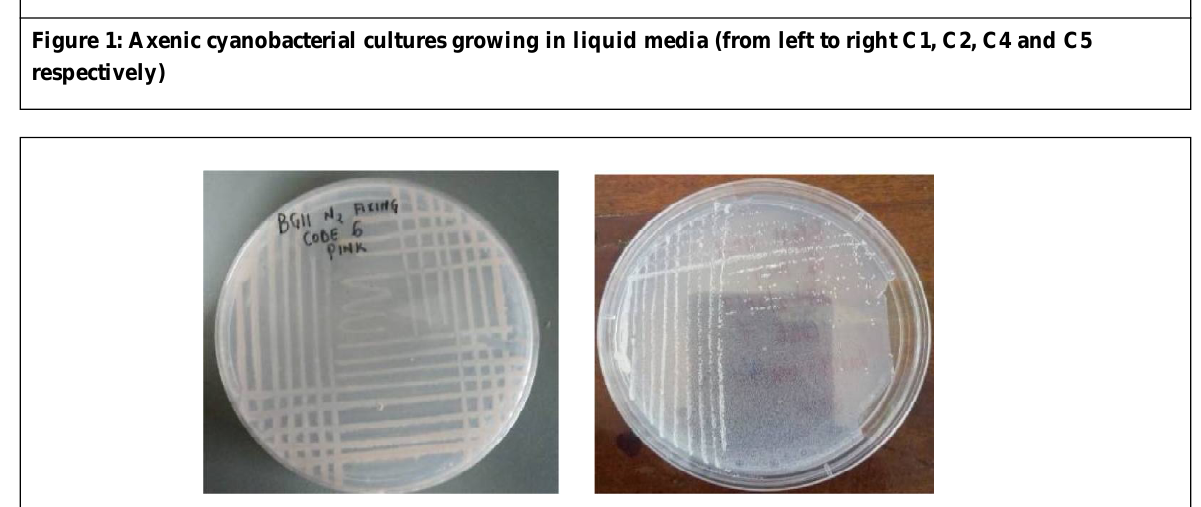
Figure 2: Axenic cyanobacterial cultures growing in solid media (from left to right Isolate C16 and C13